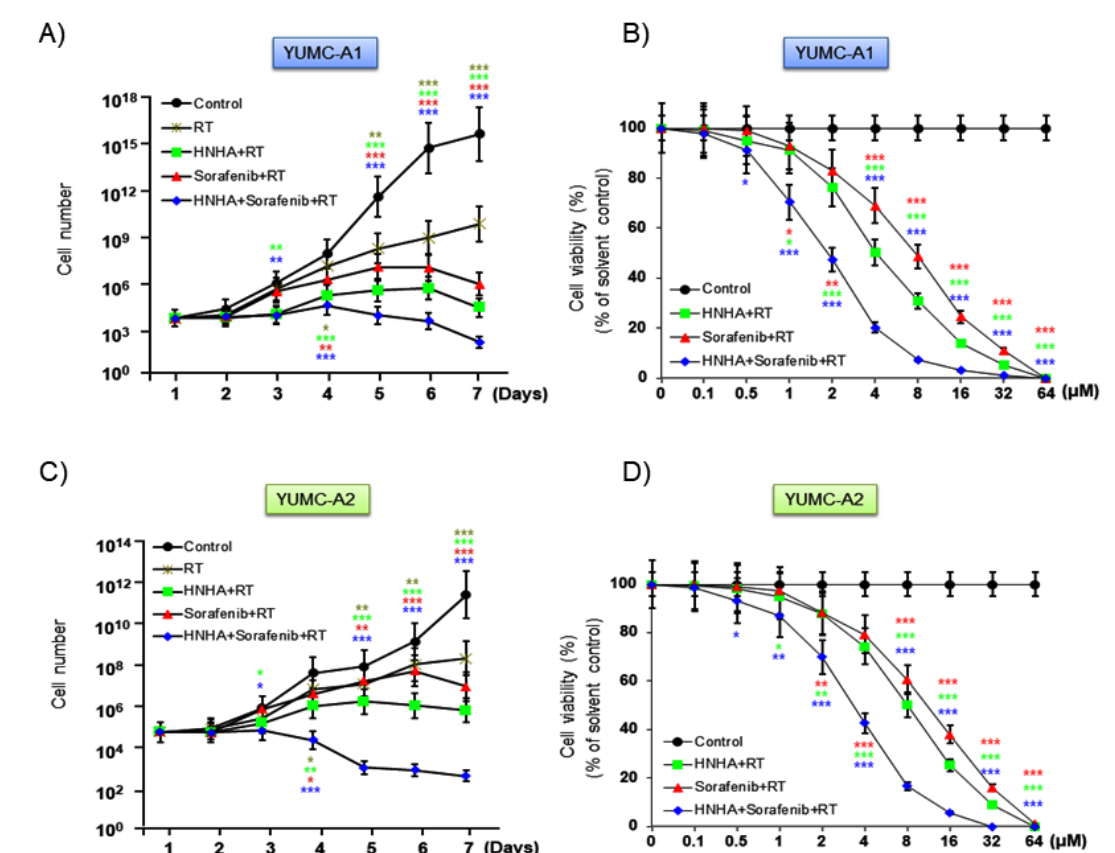
Figure 3. Synergistic anticancer effect of HNHA, sorafenib, and radiation on patient-derived thyroid cancer cells compared with the effects of each agent alone with radiation. Cell viability and proliferation assay of HNHA and sorafenib combined, each agent alone, or HNHA and sorafenib combined with radiation on patient-derived ATC cell lines. YUMC-A1 and YUMC-A2: ( A , B ) YUMC-A1 and ( C , D ) YUMC-A2,. Points indicate mean percentage of the value observed in the solvent-treated control. All experiments were repeated at least three times. Data represent means ± SD. * p < 0.05, ** p < 0.01, and *** p < 0.005 vs. control. Table 1. IC 50 values for the combination of HNHA, sorafenib, and radiation therapy (RT) in YUMC-A1 and YUMC-A2 cells. Each data point signifies the mean of three independent MTT assays, performed in triplicate. SEM, standard error of the mean. MTT, 3-(4,5-dimethylthiazol-2-yl)-2,5-diphenyltetrazolium bromide. * is lowest half maximal inhibitory concentration. Cell